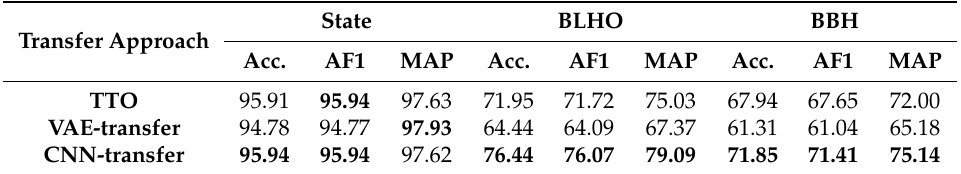
Table 5. Accuracies, Average F1-Scores, and MAPs (in %) obtained by TTO, VAE-transfer, and CNN-transfer for the state, BLHO, and BBH classification problems in the subject-dependent configuration. The best performances for each classification problem and evaluation metric are highlighted in